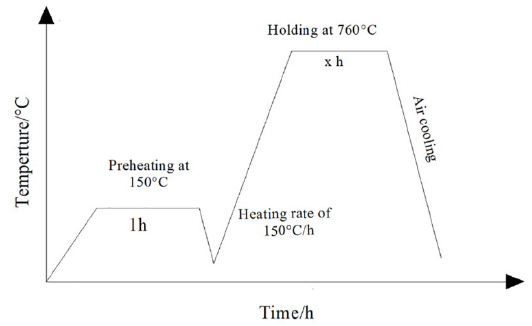
Figure 2. The process curve of the annealing